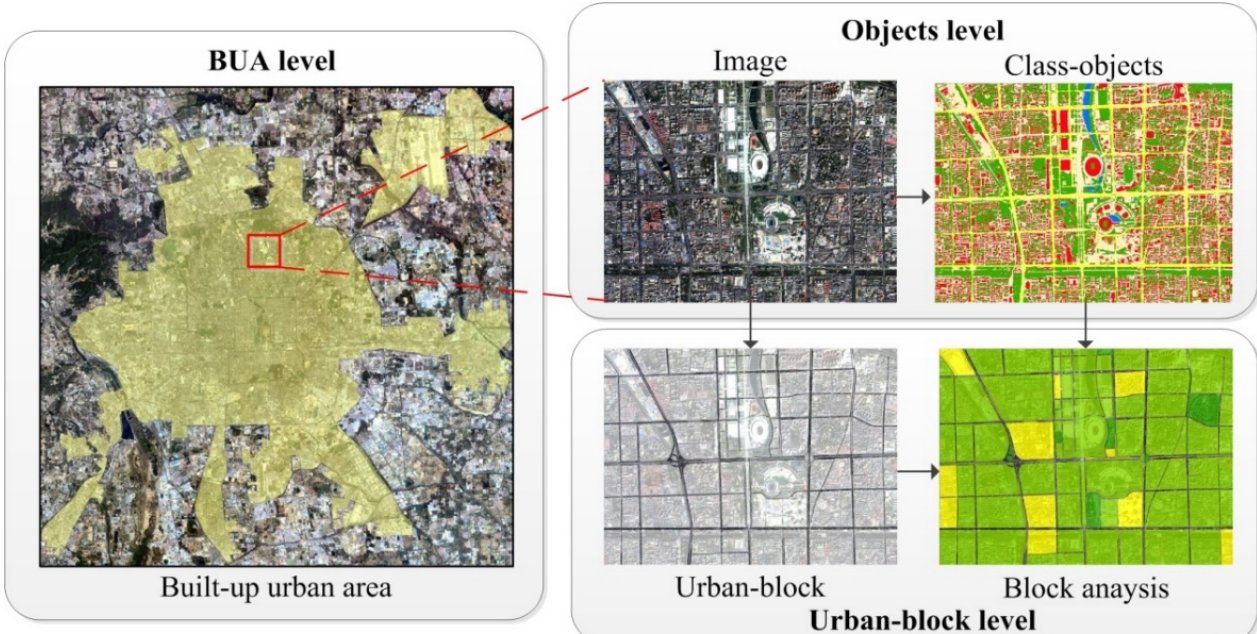
Figure 4. Framework for the quantitative analysis of multi-scale urban landscape patterns.